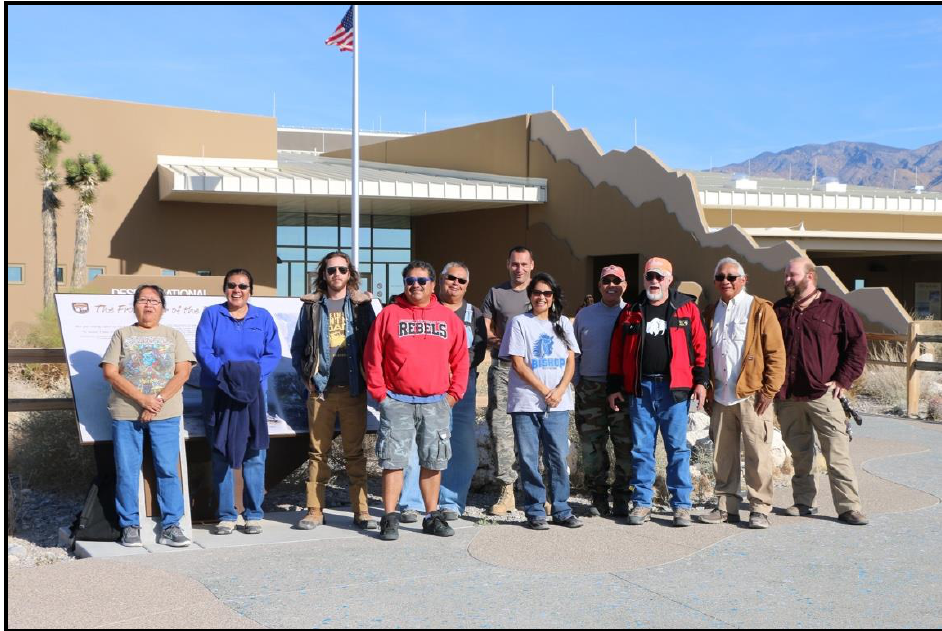
Figure 4. The 2017 3C Field Team included three UofA ethnographers and eight members of the CGTO Writers Committee at Corn Creek Headquarters for the DNWR (Source: Stoffle).